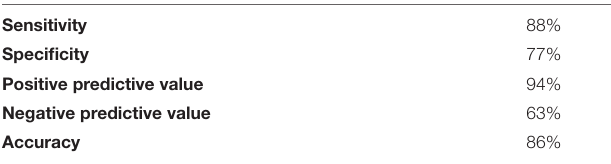
TABLE 2 | Sensitivity and specificity of ICG-guided tumor localization.